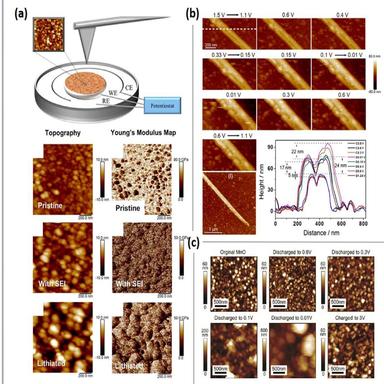
(a) The setup for in-situ AFM test (upside), topography and Young's Modulus changes during the lithiation of thin-film silicon anodes (downside) (Reproduced with permission from ref. Copyright 2019 American Chemical Society); (b) real-time AFM height images of a single Si NW anode during the first lithiation/delithiation (Reproduced with permission from ref. Copyright 2014 American Chemical Society); (c) in-situ AFM images of MnO electrodes surface at different voltage during th